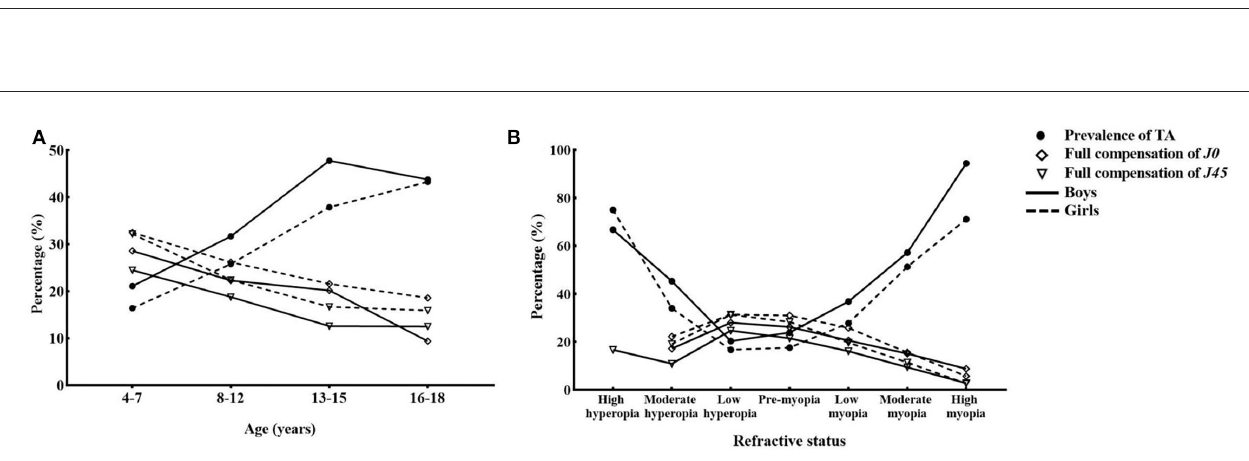
FIGURE3 Age (A) and refractive status (B) related changes in full compensation and total astigmatism. J0 and J45 components represented the orthogonal (power of Jackson cross cylinder at 90 ◦ and 180 ◦ ) and oblique (power of the Jackson cross cylinder at 45 ◦ and 135 ◦ ), respectively. The percentage of TA and full compensation in J0 , J45 components are shown on the y-axis. The groups of age and refractive status are shown on the x-axis. After cycloplegia, pre-myopia was defined as − 0.50 D < SE ≤ 0.75 D. We classified myopia as mild myopia ( − 3.00 D < SE ≤ − 0.5 D), moderate myopia ( − 6.00 D) < SE ≤ 3.00 D, and high myopia (SE ≤ − 6.00 D) after cycloplegia. We classified hyperopia as mild myopia ( − 0.75 D < SE ≤ 2.00 D), moderate myopia (2.00 D < SE ≤ 5.00 D), and high hyperopia (SE > 5.00 D). TA, Total Astigmatism; D,